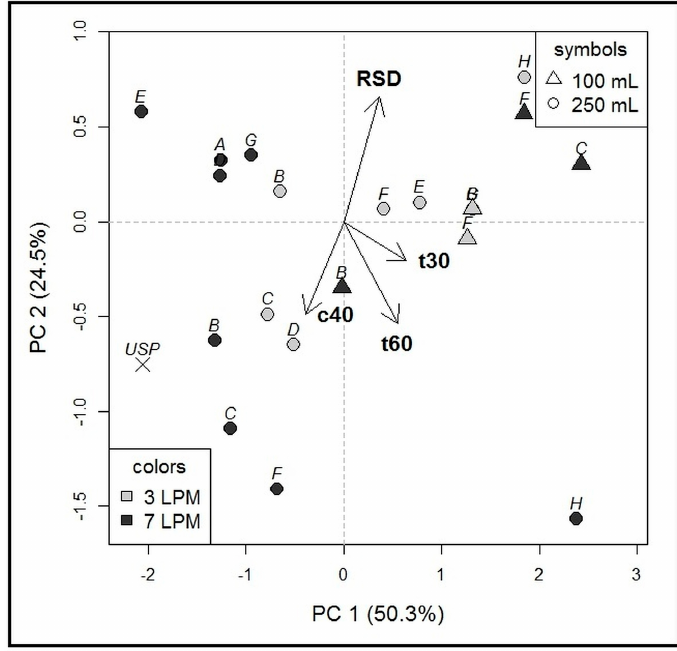
Figure 7. Complex PCA biplot for merged data from Phase 1 and Phase 2. The multivariant analysis